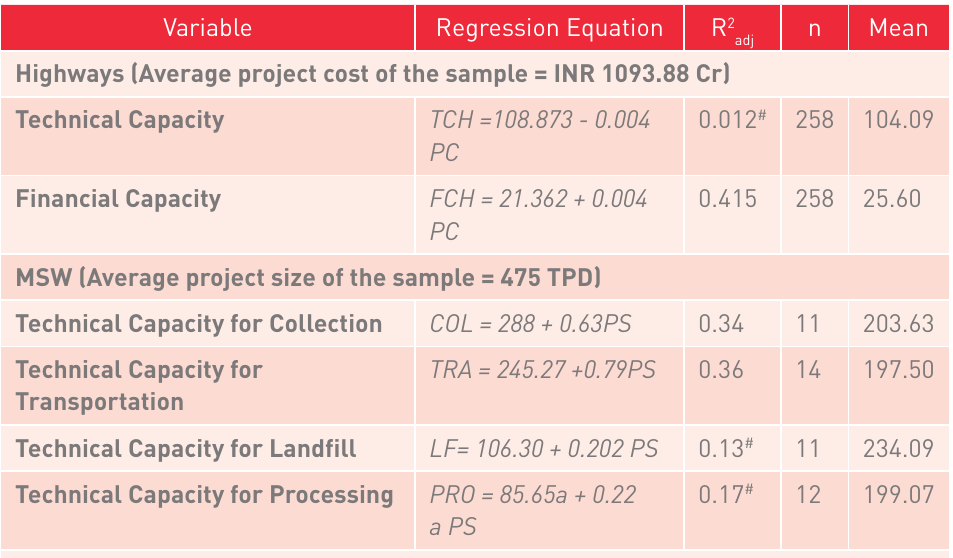
Regression models between project attributes and capacity